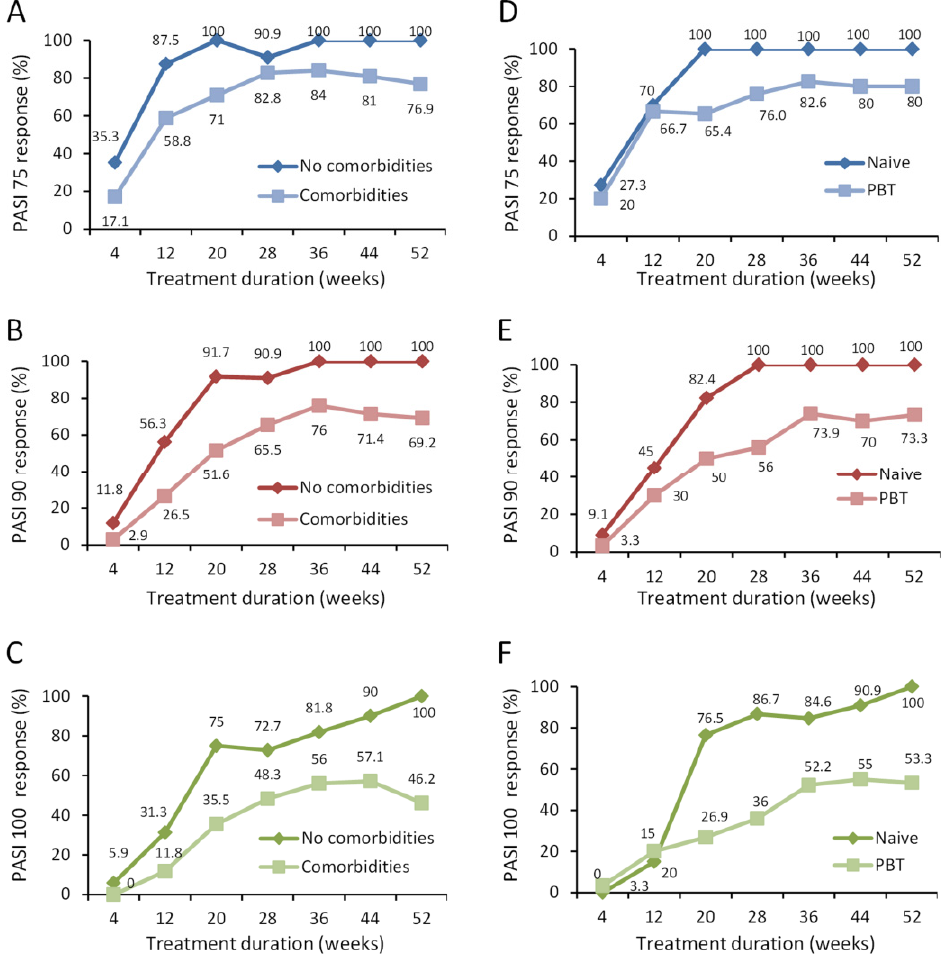
Figure 2. Effect of guselkumab in subgroups of psoriatic patients on achievement of PASI 75, 90, and 100 response over 1 year. ( A – C ) The % patients with comorbid diseases ( n = 35) compared to those without comorbid diseases ( n = 17) in achieving PASI 75 ( A ), 90 ( B ), and 100 ( C ) response are presented for each time point. ( D – F ) The % patients naïve to previous biological treatment ( n = 22) compared to those having previously received biological treatment (PBT; n = 30) in achieving PASI 75 ( D ), 90 ( E ), and 100 ( F ) response are presented for each time point. The % of patients at each time point is